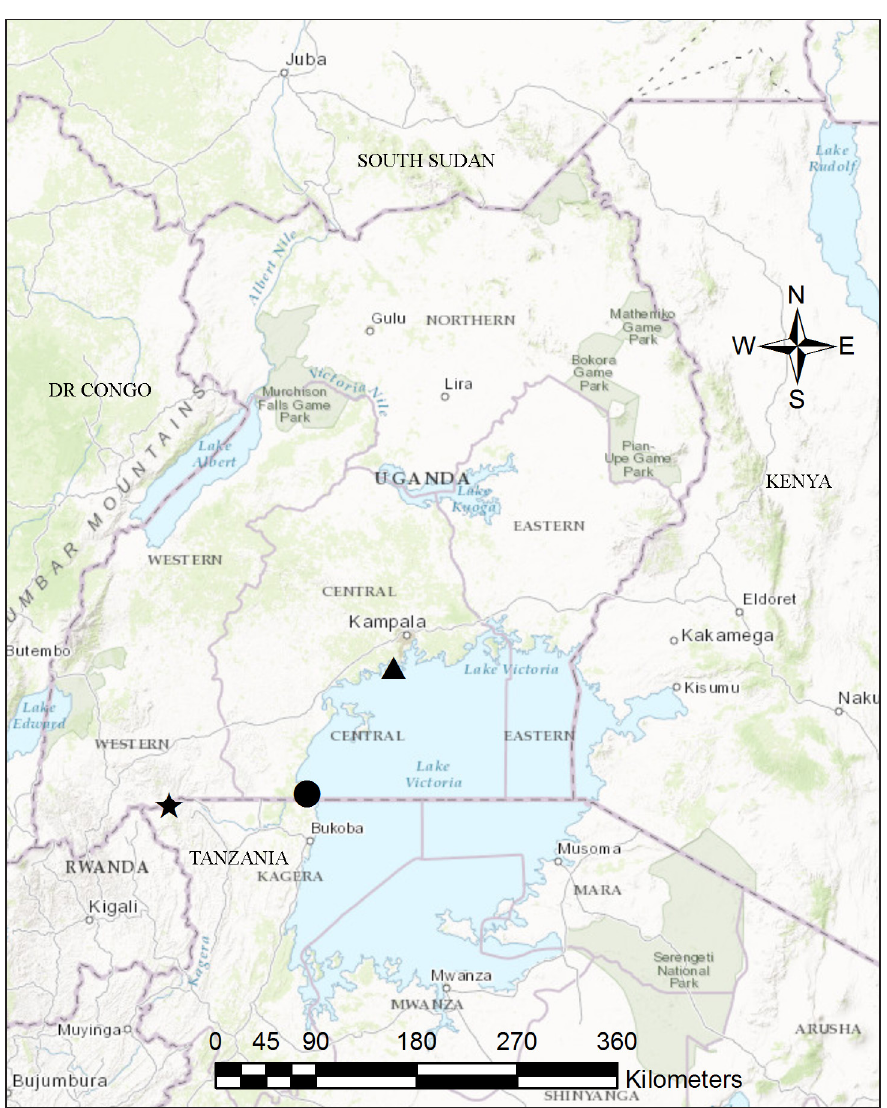
Fig. 7. Distribution map showing the known localities of Potamonautes entebbe sp. nov. (black triangle), P. busungwe sp. nov. (black circle) and P. kantsyore sp. nov. (black star) in Uganda, East Africa. For exact localities, see